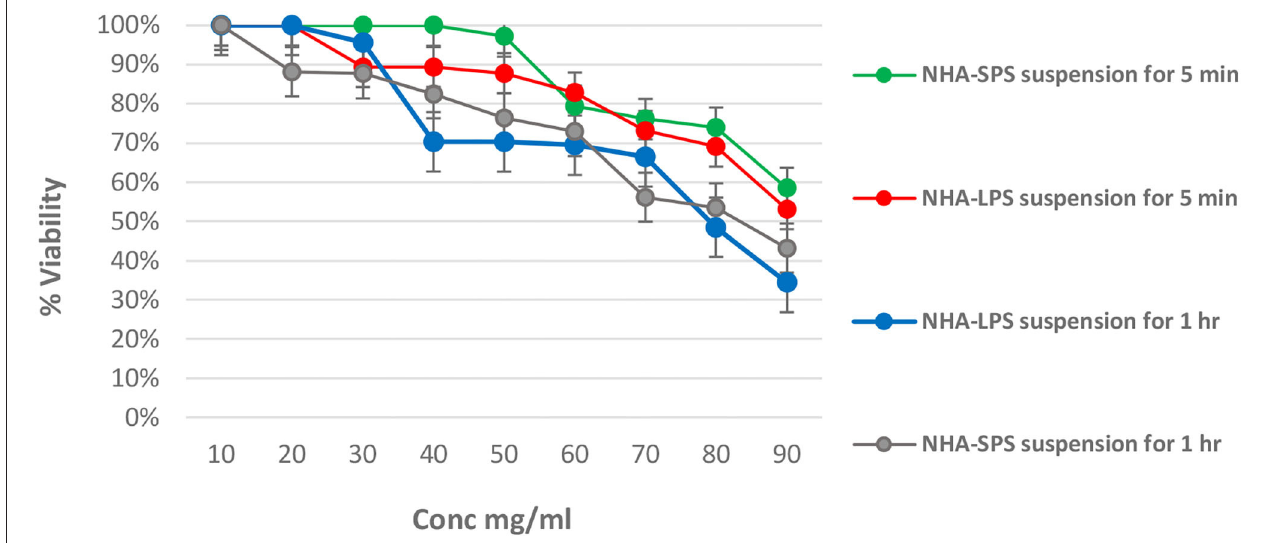
FIGURE 3 | Effect of test NHA suspensions on the viability of normal fibroblasts at different time intervals. (A) For NHA-SPS suspension for 5min. (B) NHA-LPS suspension for 5min. (C) NHA-LPS suspension for 1h. (D) NHA-SPS suspension for 1h.